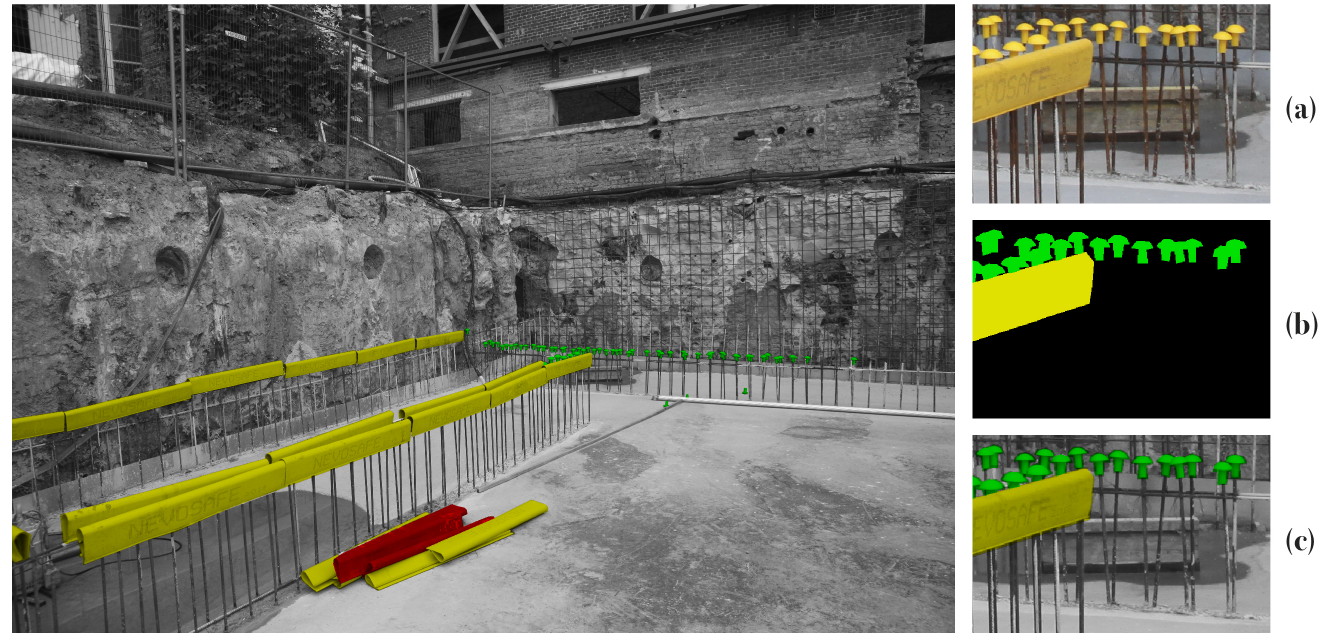
5616 gray-scale image with ×